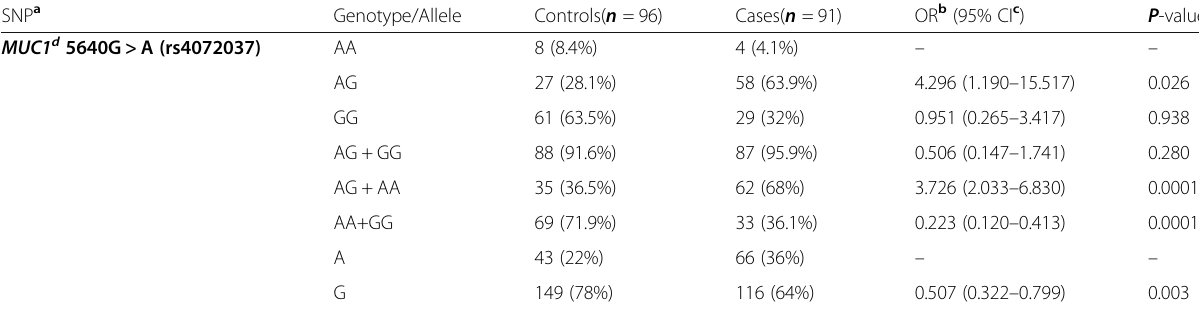
Table 4 Comparison of genotype and allele frequencies of MUC1 gene polymorphisms between gastric cancer patients ( n = 91) and normal controls ( n = 96) using chi-square analysis SNP a